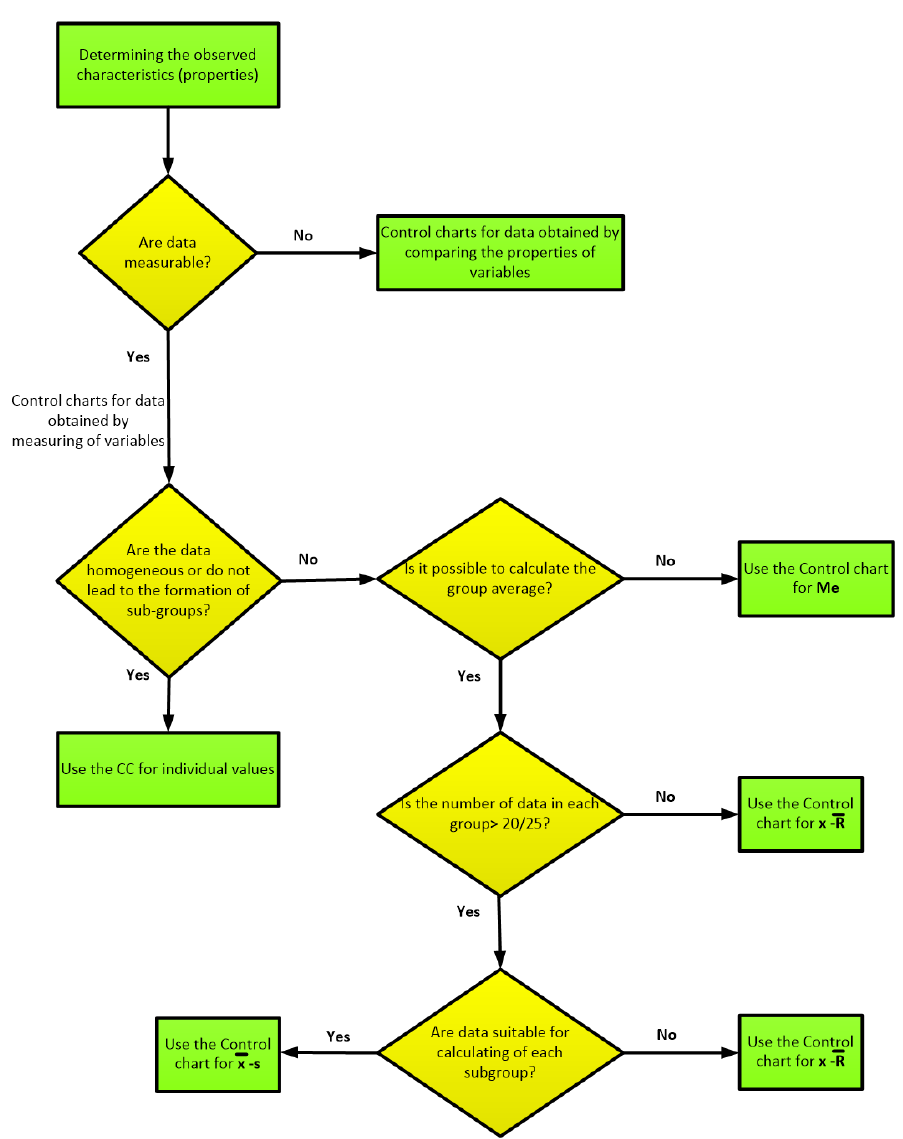
Figure 9. A simple algorithm for the application of control